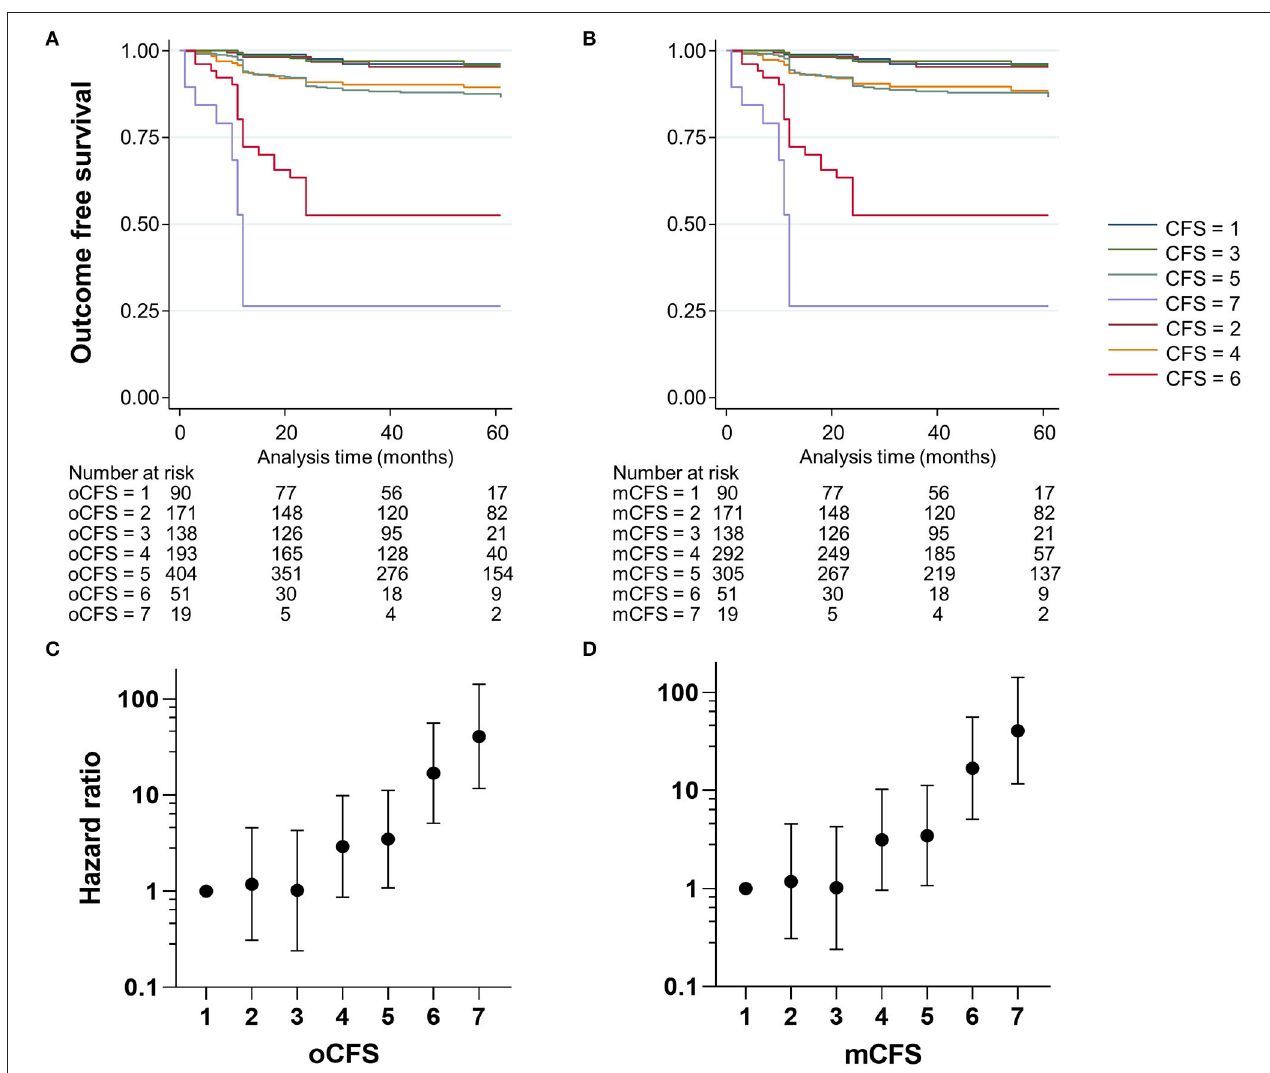
FIGURE 2 | Kaplan–Meier plots showing the incidence of the composite outcome according to clinical frailty scale scores, by original classification tree [oCFS, (A) ] and culturally modified classification tree [mCFS, (B) ], and plots showing hazard ratios (dots) and 95% confidence ratio (whiskers) of the composite outcome by oCFS (C) and mCFS (D)